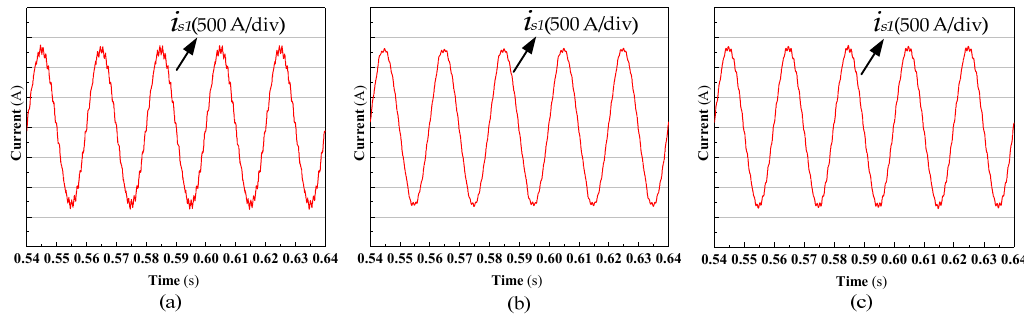
Figure 10. Simulated waveforms of secondary-side current ( i s 1 ): ( a ) IFI-based L-type filter; ( b ) discrete inductor-based LCL-type filter; ( c ) IFI-based LCL-type filter.